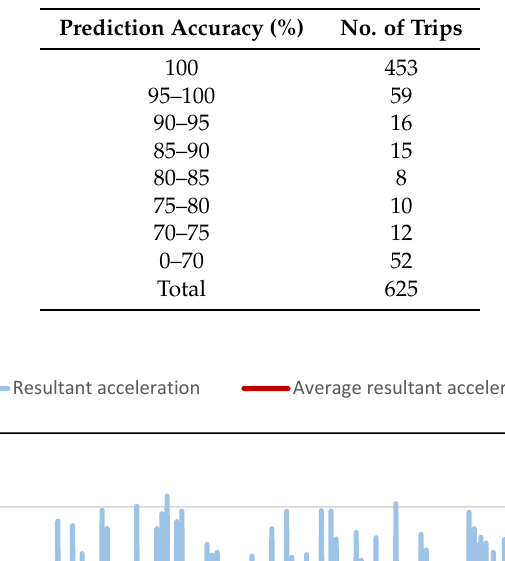
Table 9. Classification results of trips for 0.2 Hz data.